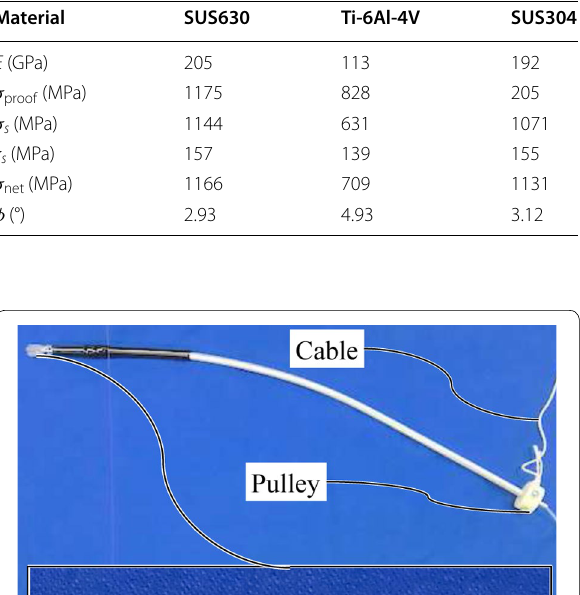
Table 3 Candidate of f H for the 3.5 mm inner pipe Candidate No.